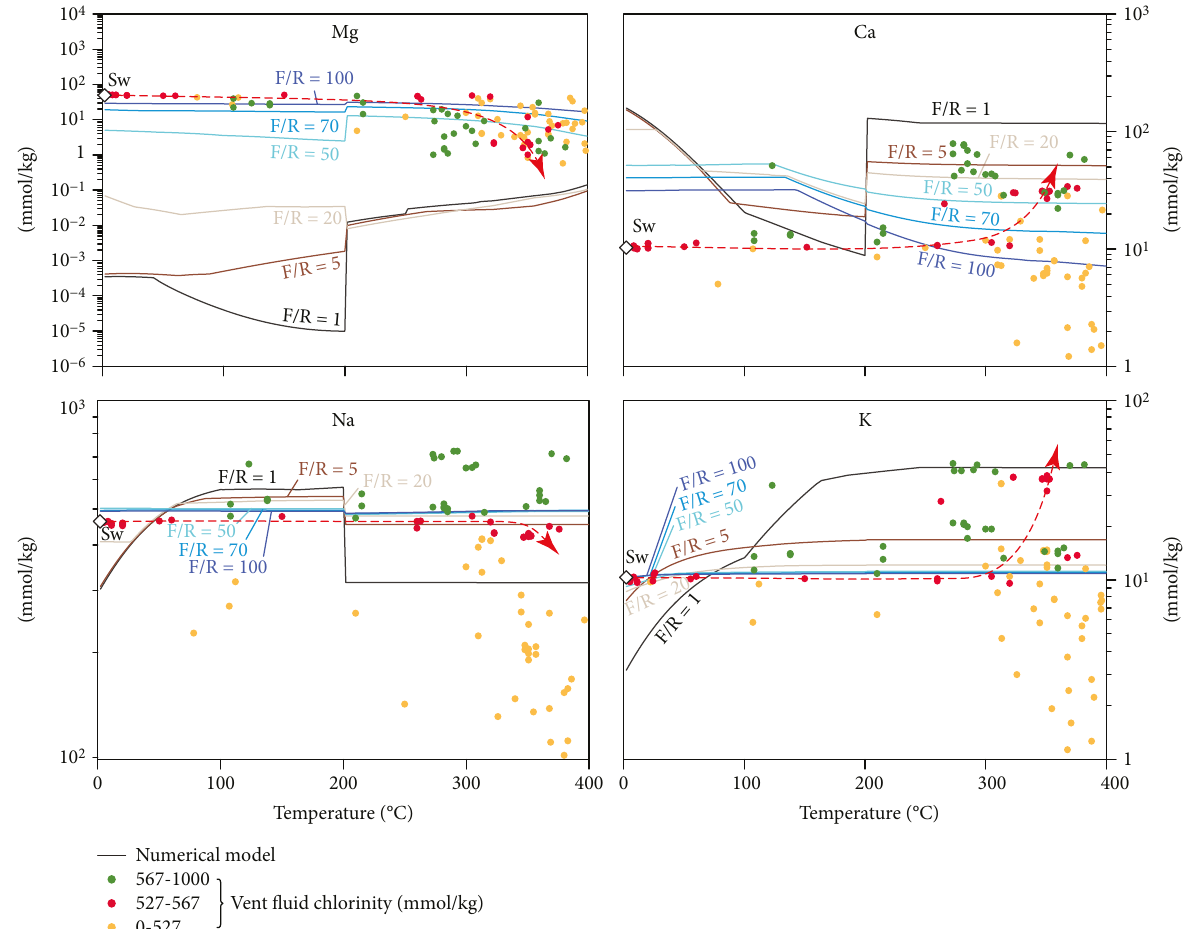
Figure 5: Comparison between the simulated fl uid compositions (lines) and natural vent compositions at mid-ocean ridges and analogous submarine basalt-dominated environments (dots) for the total dissolved cation compositions of Mg, Ca, Na, and K. The natural vent compositions are sorted with respect to their associated chlorinities. Vent geochemical data are provided in Table 2. Orange dots represent a Cl value of 0 – 527mmol/kg, red dots represent a Cl value of 527 – 567mmol/kg, and green dots represent a Cl value of 567 – 1000mmol/ kg. Dashed red arrows show the trends of natural fl uid samples with a chlorinity corresponding to the value of seawater at 2 ° C (Cl Sw ° C =546.7mmol/kg ± 20 mmol/kg). White diamonds represent the composition of seawater at 2 ° C. The seawater-basalt simulations were carried out from 2 to 400 ° C, 500 bars, and variable fl uid/rock (F/R) mass